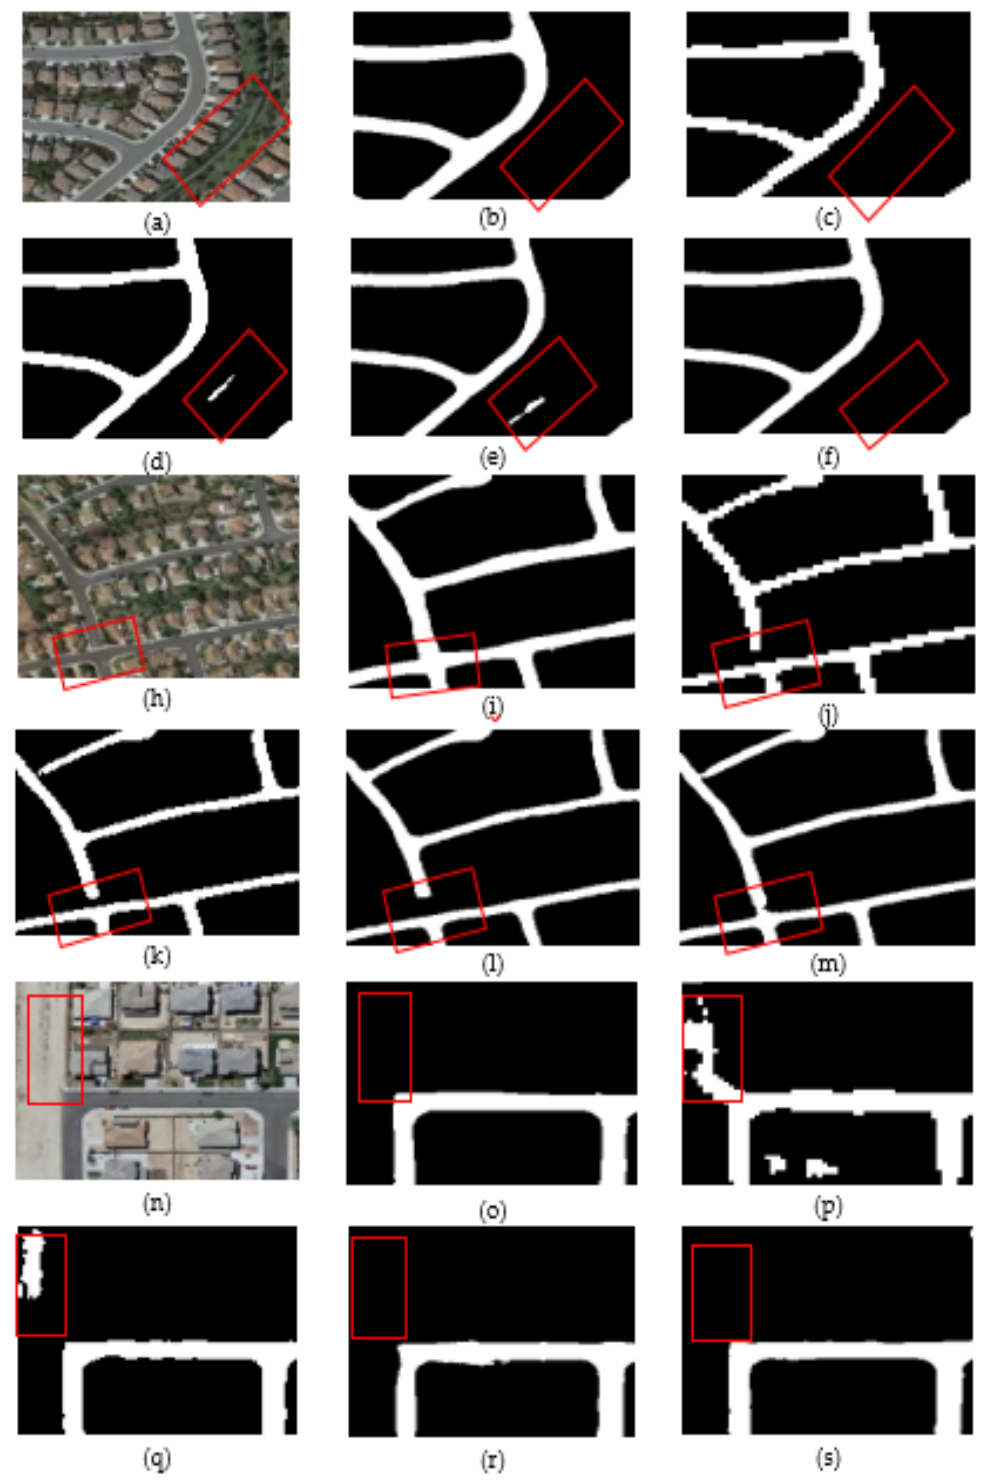
Figure 7. Comparison of the results between the proposed model and di ff erent models: ( a , h , n ) the original images, ( b , i , o ) the ground truth images, ( c , j , p ) the predictions of the first model, ( d , k , q ) the predictions of the second model,( e , l , r ) the predictions of the third model, and ( f , m , s ) the predictions of the proposed model.